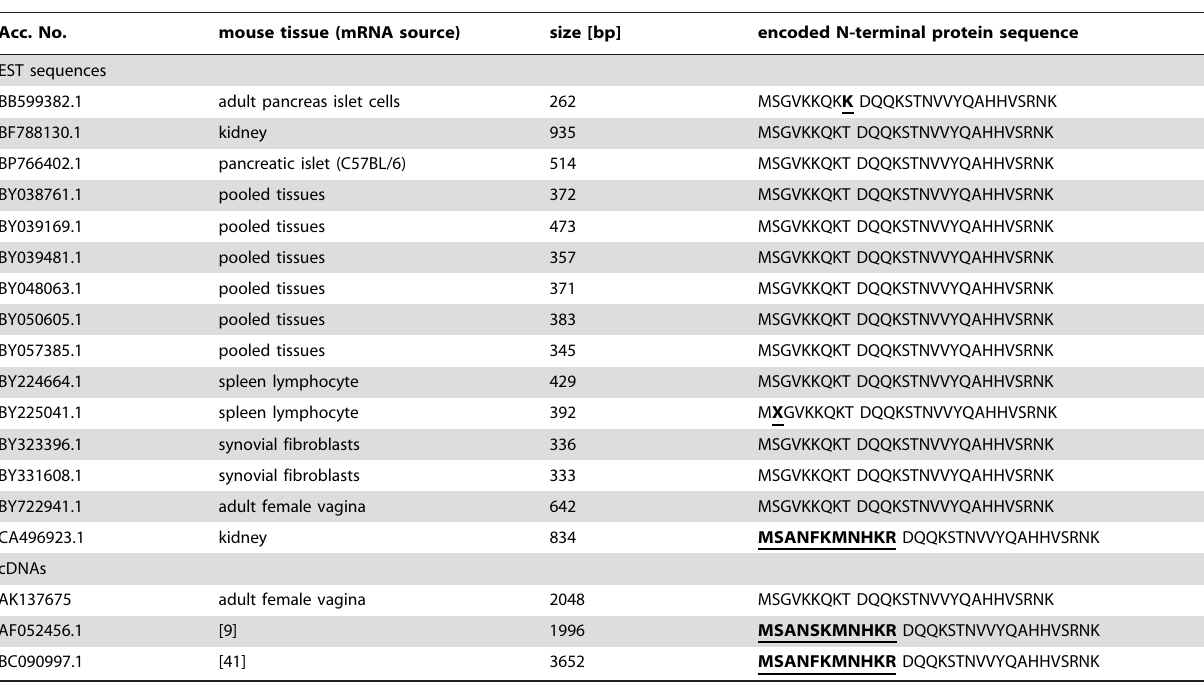
Table 2. Supporting evidence for an alternative mouse PAPSS2 N-terminus.